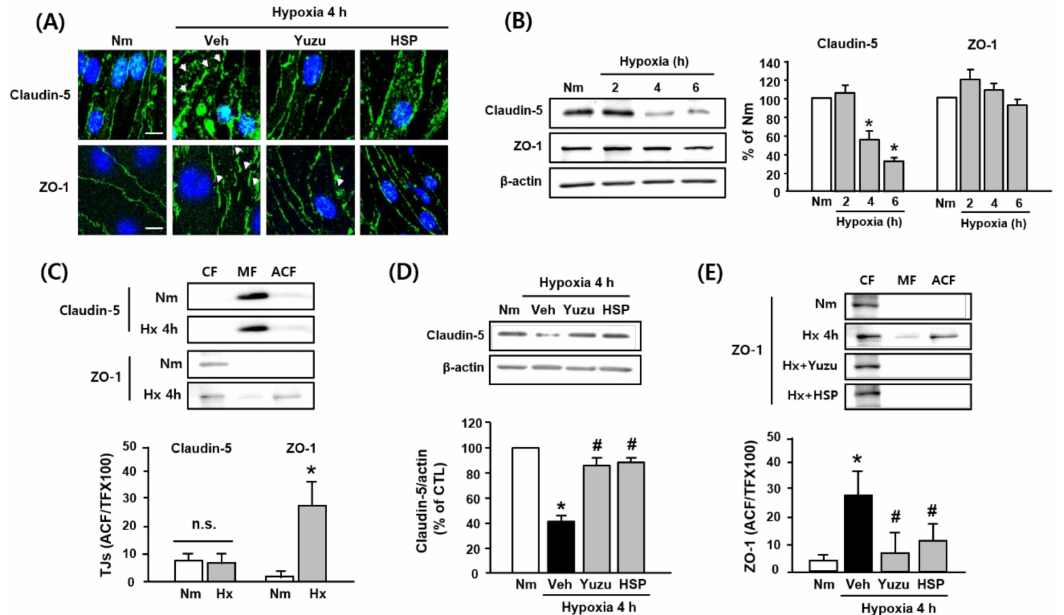
Figure 3. E ff ects of yuzu and hSP on disruption of claudin-5 and ZO-1 during hypoxia in bEnd.3 cells. ( A ) Representative fluorescence images of disruption of claudin-5 and ZO-1 induced by 4 h of hypoxia in brain endothelial cells. Arrows indicate regions of tight junction protein disruption. Green: claudin-5- or ZO-1-conjugated FITC, blue: hoechst. Scale bar, 20 µ m. ( B – E ) Western blotting of claudin-5 and ZO-1. ( B ) Protein levels of claudin-5 and ZO-1 during hypoxia (2, 4, and 6 h). ( C ) Redistribution of claudin-5 and ZO-1 during at 4 h of hypoxia in each fraction of bEnd.3 cells. ( D ) E ff ect of yuzu and hSP on degradation of claudin-5 at 4 h of hypoxia. ( E ) E ff ect of yuzu and hSP on redistribution of ZO-1 at 4 h of hypoxia. Data are shown as mean ± SEM. ( n = 5–7) * p < 0.05 vs. nm, # p < 0.05 vs. Veh. nm: normoxia; Veh: vehicle; h: hypoxia; hSP: hesperidin; CF: cytosolic fraction; MF: membrane fraction; ACF: actin cytoskeleton